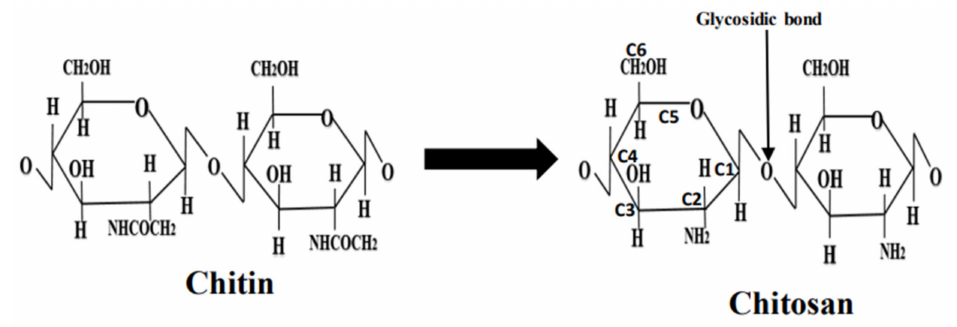
Figure 1. Molecular conversion of chitin to